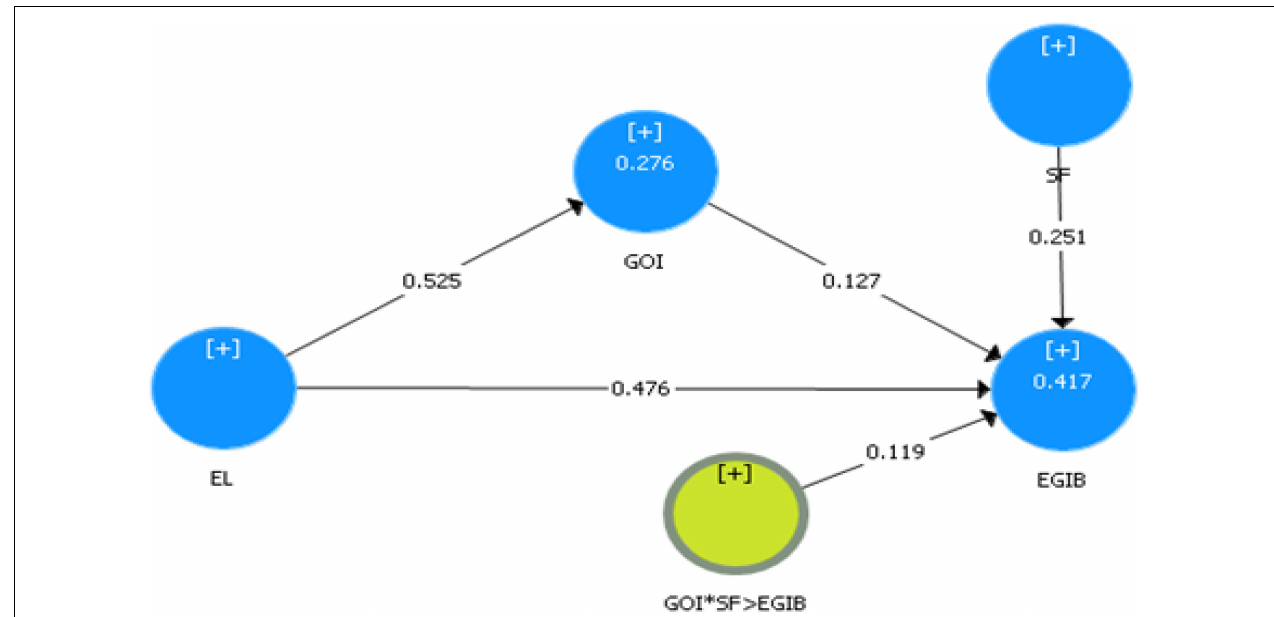
FIGURE 2 | Hypotheses testing of